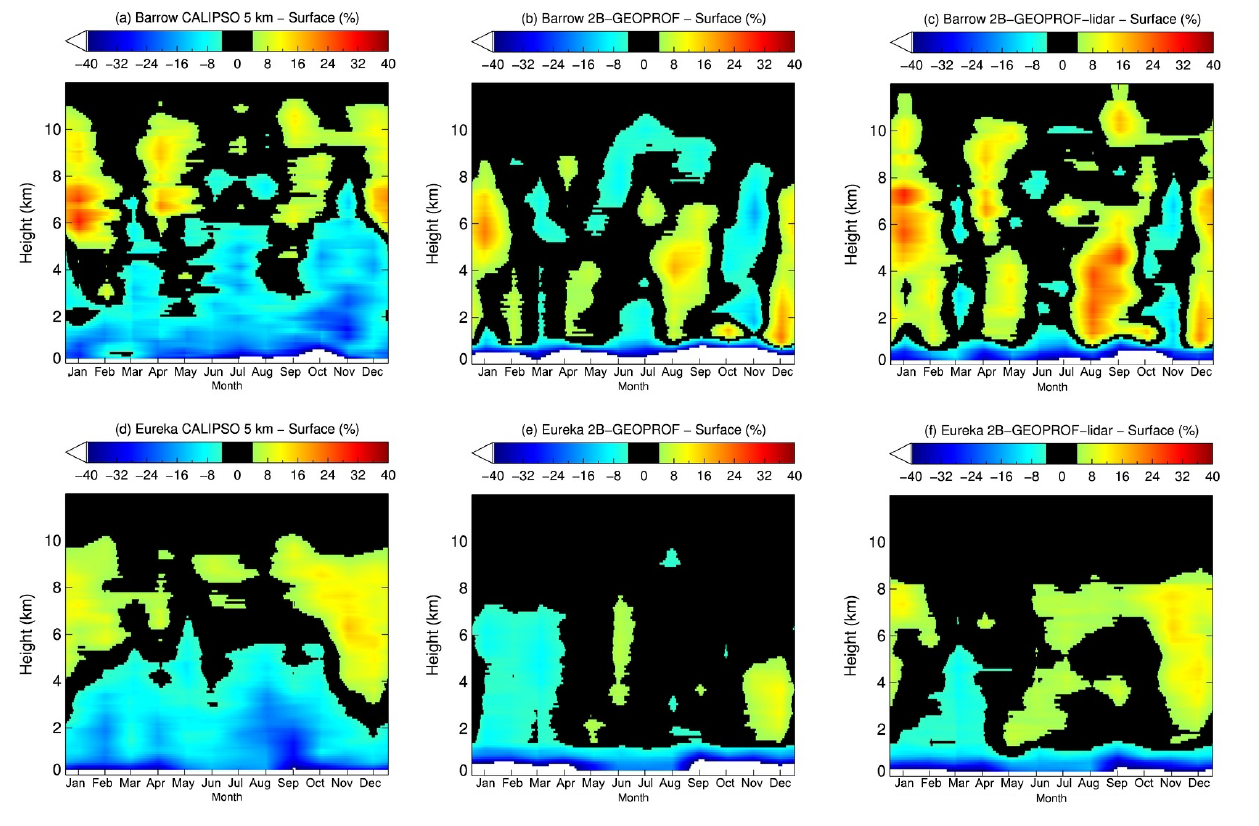
Figure 3. Cloud fraction vertical distribution difference for 2006–2010 from (a) CALIPSO 5km, (b) 2B-GEOPROF, and (c) 2B-GEOPROF- lidar and surface observations at Barrow; from (d) CALIPSO 5km, (e) 2B-GEOPROF, and (f) 2B-GEOPROF-lidar and surface observations at